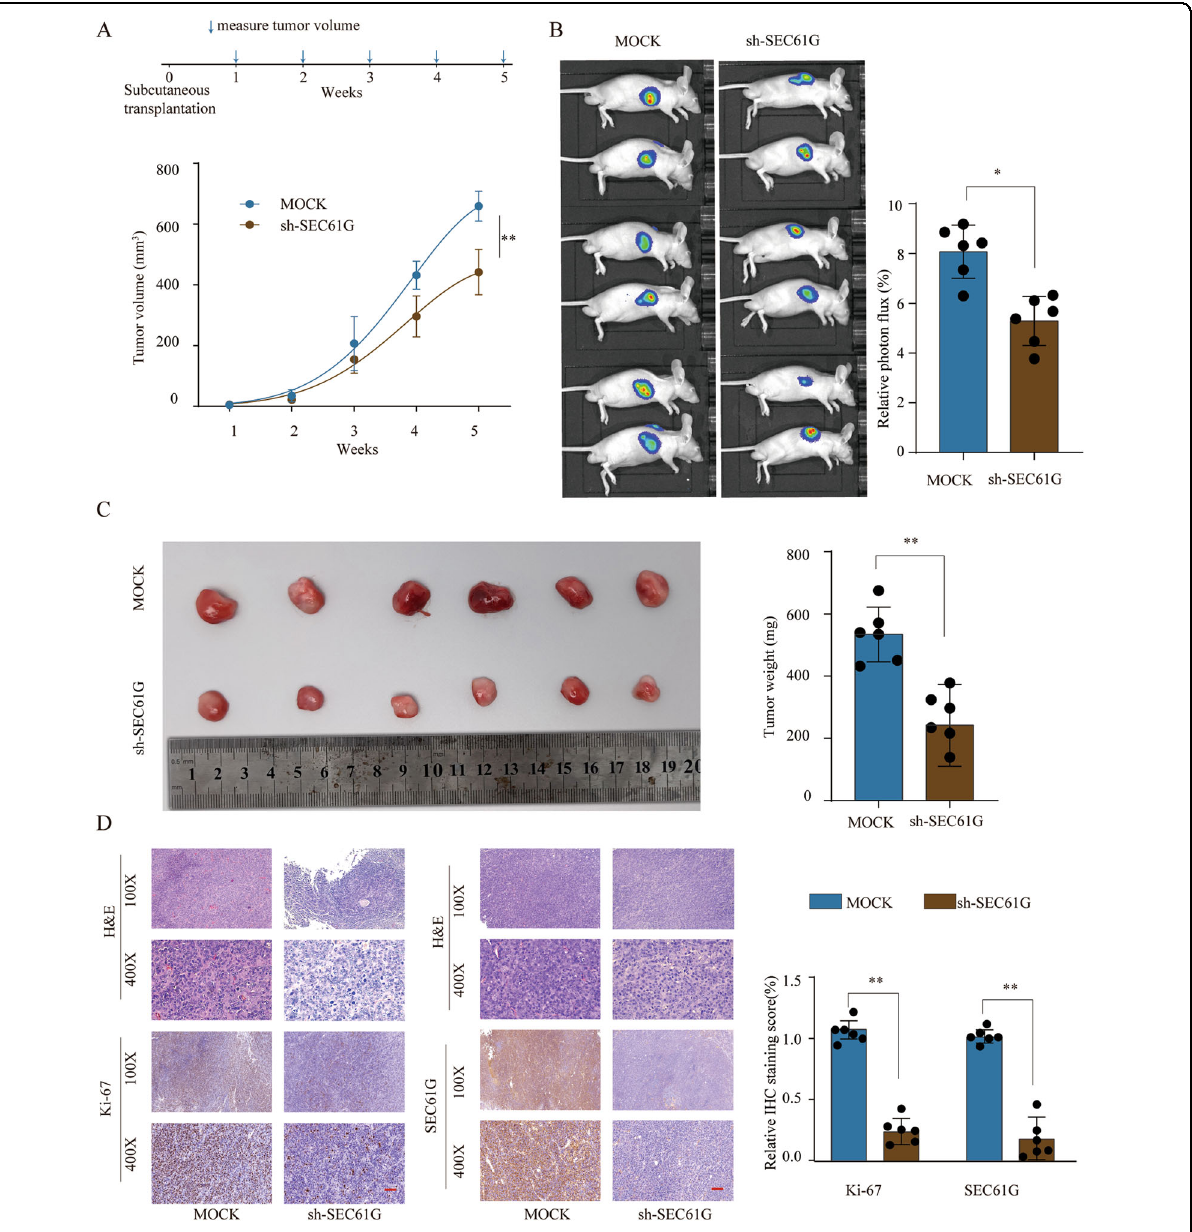
Fig. 4 Knockdown of SEC61G inhibits breast cancer xenograft tumor development in vivo. Breast cancer MDA-MB-231 cells stably transfected with Mock or sh-SEC61G were implanted subcutaneously into nude mice to establish a xenograft tumor model and tumor growth was analyzed. A Growth curves of the tumor were examined based on tumor size measured every week ( n = 6). B The relative photon fl ux of breast tumors in nude mice from the Mock or sh-SEC61G group was examined using a live imaging system to measure the luciferase signal. C Representative photographs of xenograft breast tumor tissues from the Mock and sh-SEC61G groups at week 5 were shown and tumor weights were analyzed. D Representative H&E staining and IHC staining images of SEC61G and Ki-67 of tumor sections from the Mock or sh-SEC61G group (left). Quanti fi cation of relative Ki-67 and SEC61G staining intensity in tumor sections from the Mock or sh-SEC61G group. * P < 0.05, ** P <